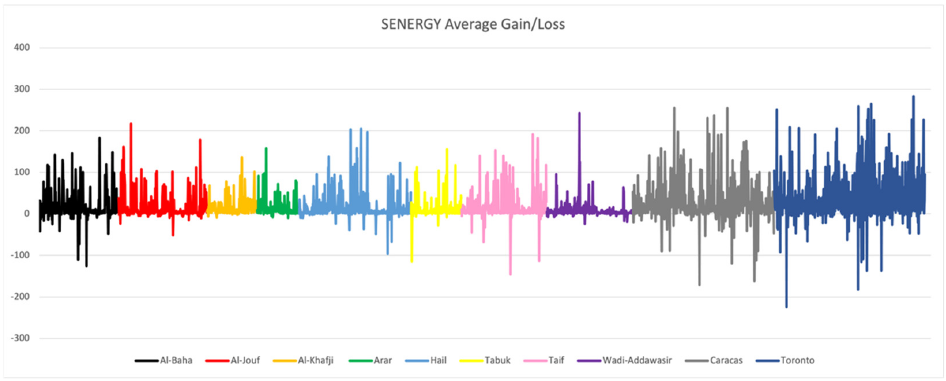
Figure 40. Average gain/loss of